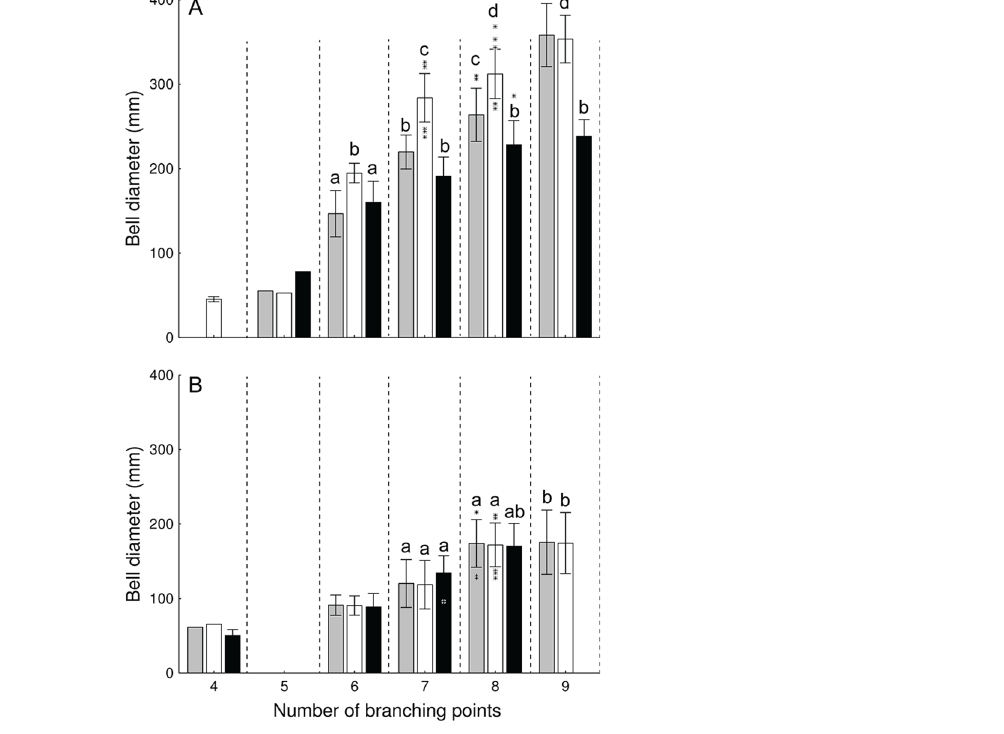
Fig 6. Relationship between bell diameter and number of branching points (i.e., age) in Aurelia medusae from the Gulf of Mexico. A: Aurelia sp. 9. B: Aurelia c.f. sp. 2. Grey (2003) and hollow (2005) bars represent medusae collected from the Central Northern Gulf of Mexico (Dauphin Island, AL), while black bars represent individuals collected in the Southeastern Gulf of Mexico (Long Key, FL 2006). Means with different letters are significantly different (Tukey ’ s, P < 0.001). Bars: SD. Asterisks: